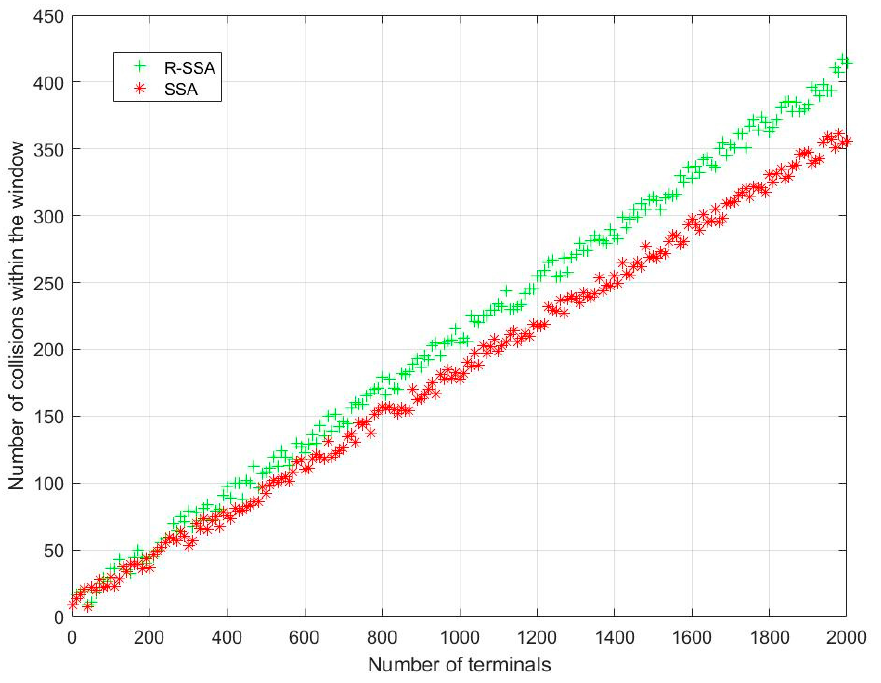
Figure 14. R-SSA vs. SSA in the number of collisions in the same collision window.